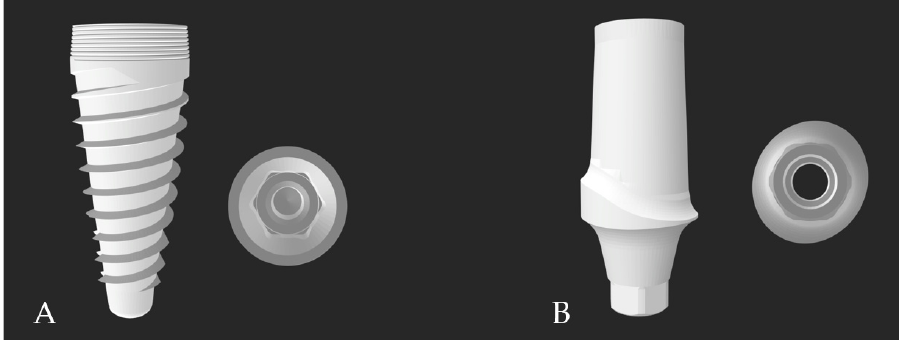
Figure 4. ( A ) Conometric connection 18° (9 ° each side); ( B ) Esthetic abutment.